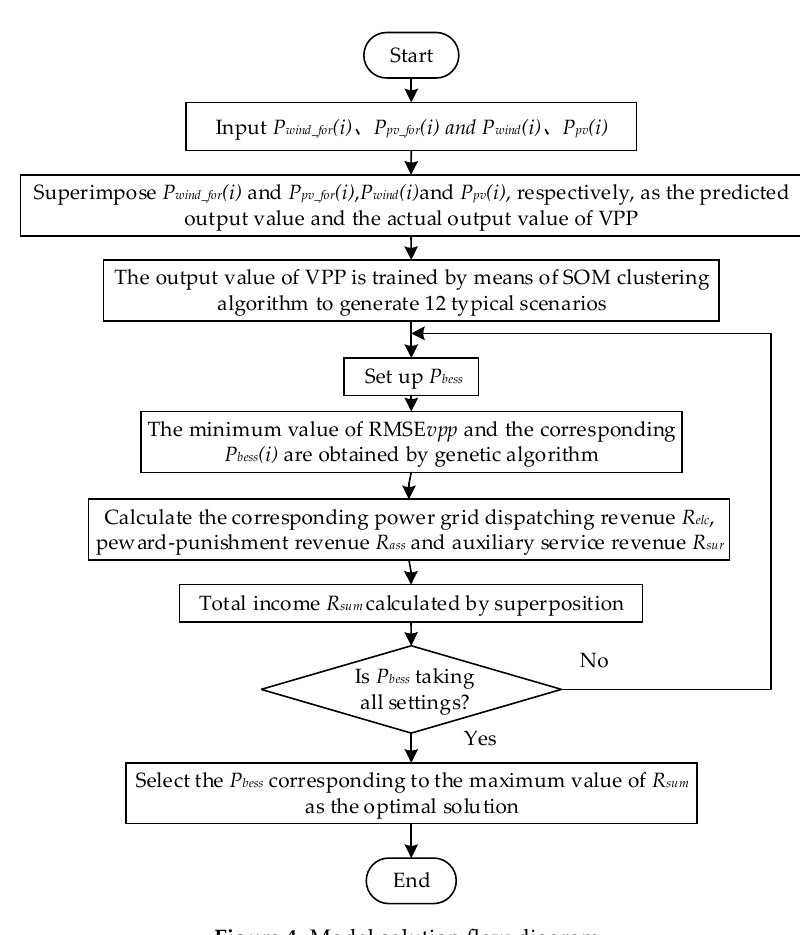
Figure 4. Model solution flow diagram.